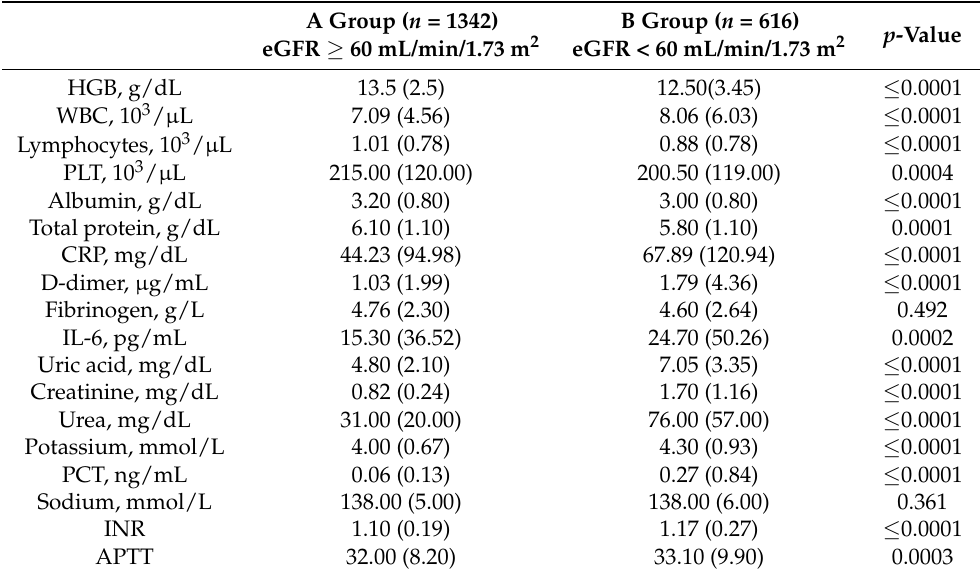
Table 2. Laboratory values of COVID-19 patients at admission to